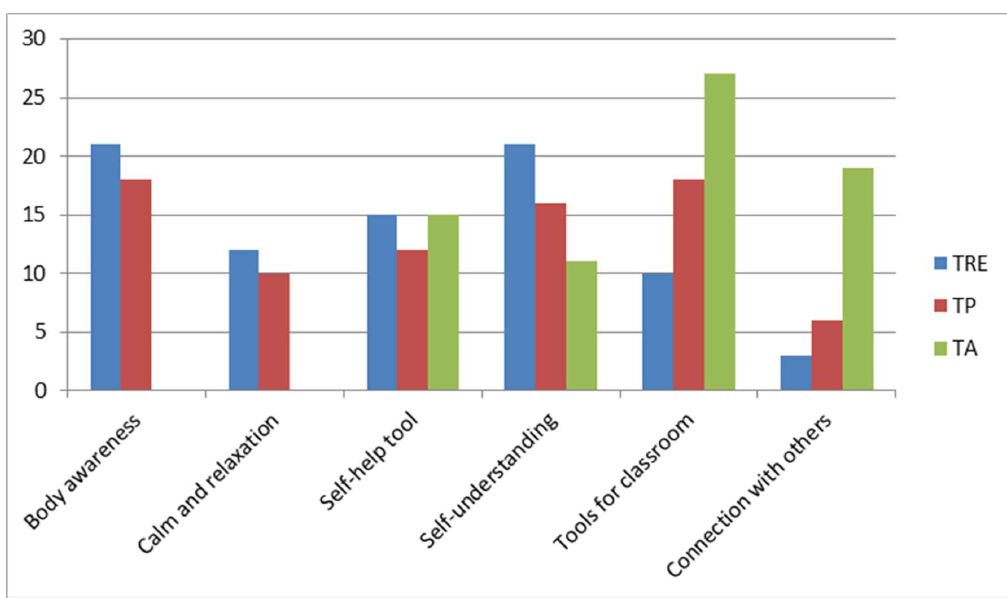
Figure 1 . Summary of impact of